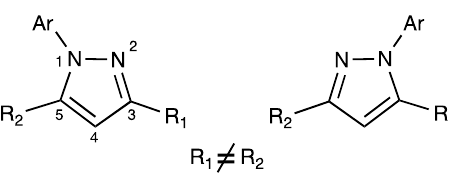
Figure 2. Pyrazole Figure 2. Pyrazole Regioisomers.